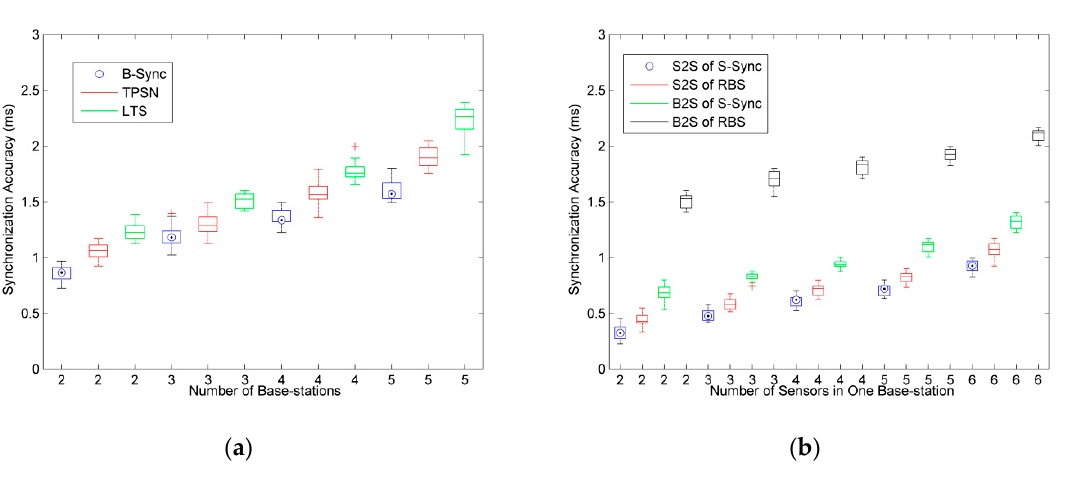
Figure 9. Comparative analysis of synchronization accuracy for base-station to base-station synchronization. ( a )Base-station to base-station synchronization; and ( b ) base-station to sensor synchronization.